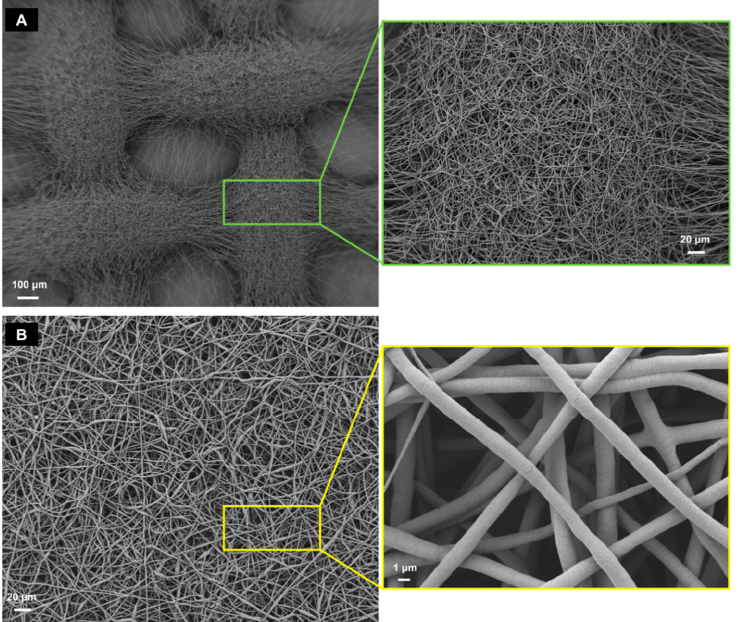
Figure 3. SEM analysis of the PCL-Patterned (A) and PCL-Randomic (B) scaffolds. PCL-Patterned scaffold is reported in A and its zoomed view is shown in a green frame. The scale bars are 100 μ m (magnification 100×) and 20 μ m (magnification 500×), respectively. The PCL-Randomic is reported in the bottom ( B ) (magnification 500×) and a higher magnification (10 k× image is shown in a yellow frame. For those images the scale bars are 10 μ m and 1 μ m, respectively.